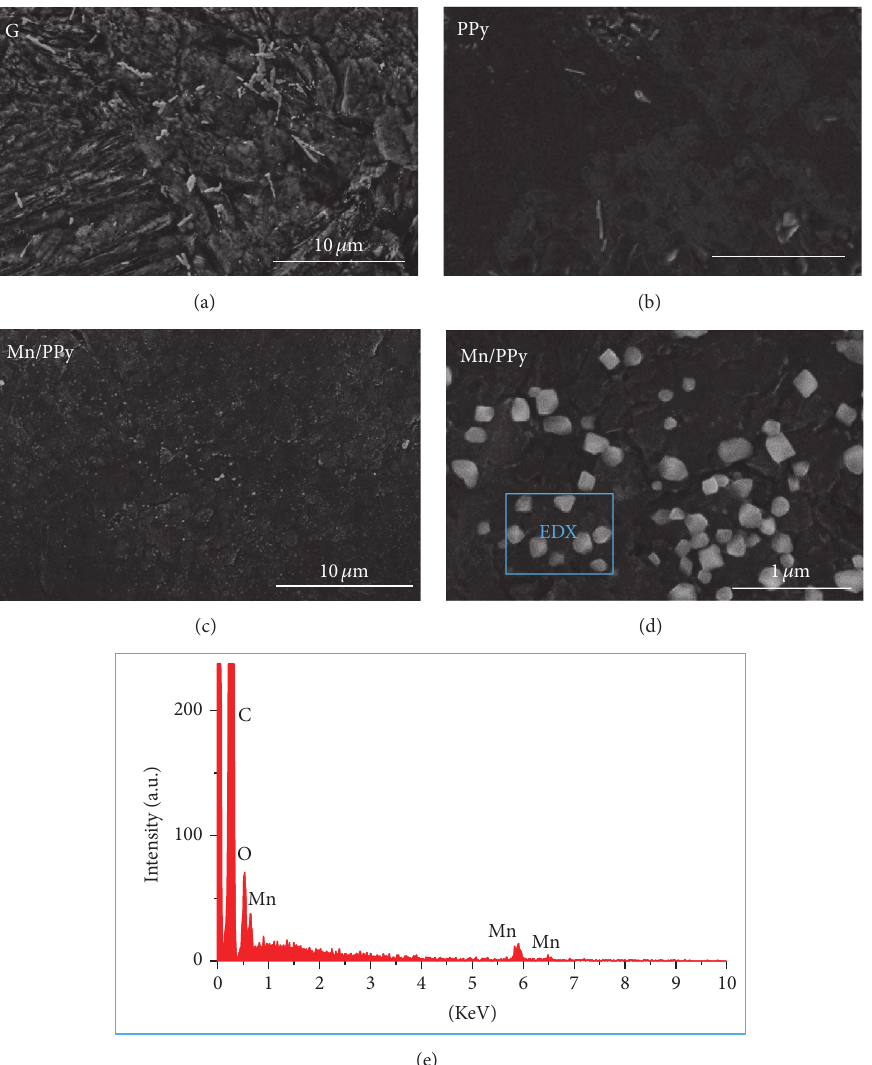
Figure 4: FE-SEM micrographs of (a) graphite, (b) PPy (PPy60/G), and (c, d) Mn/PPy electrodeposited on graphite (Mn-PPy240/G). (e) A typical EDX spectrum recorded in a representative